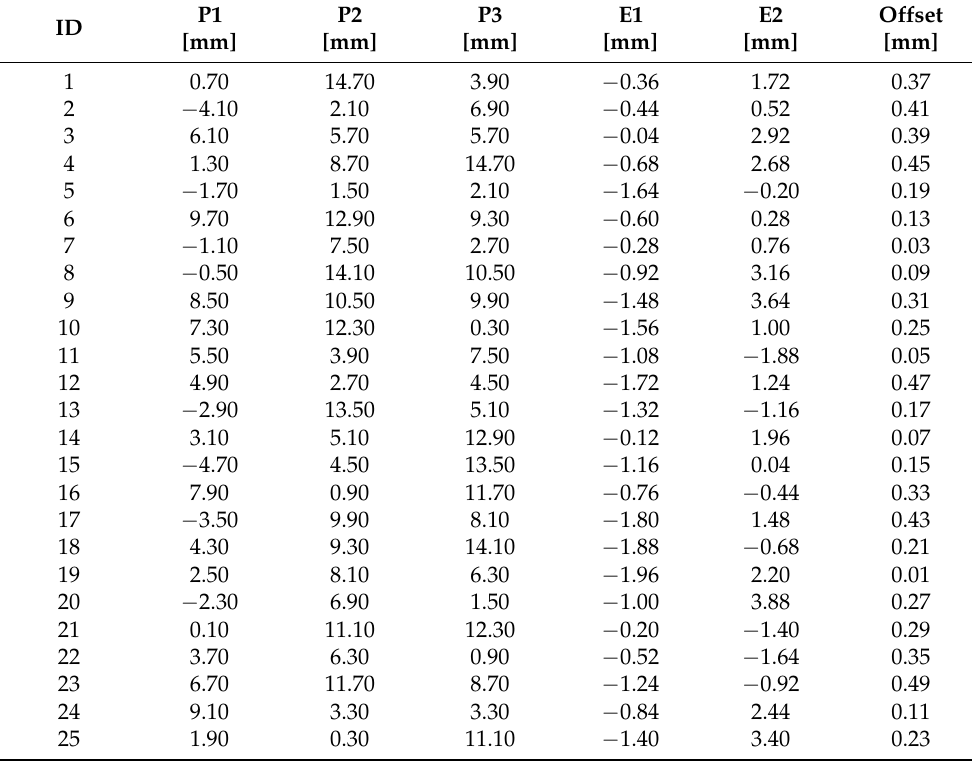
Table A2. DoE table of the Volvo test